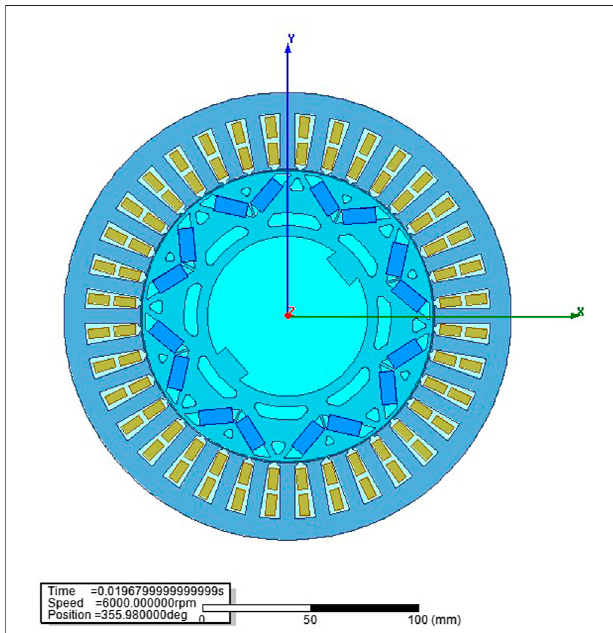
FIGURE 5 | Sectional view of the model of the CPMSM